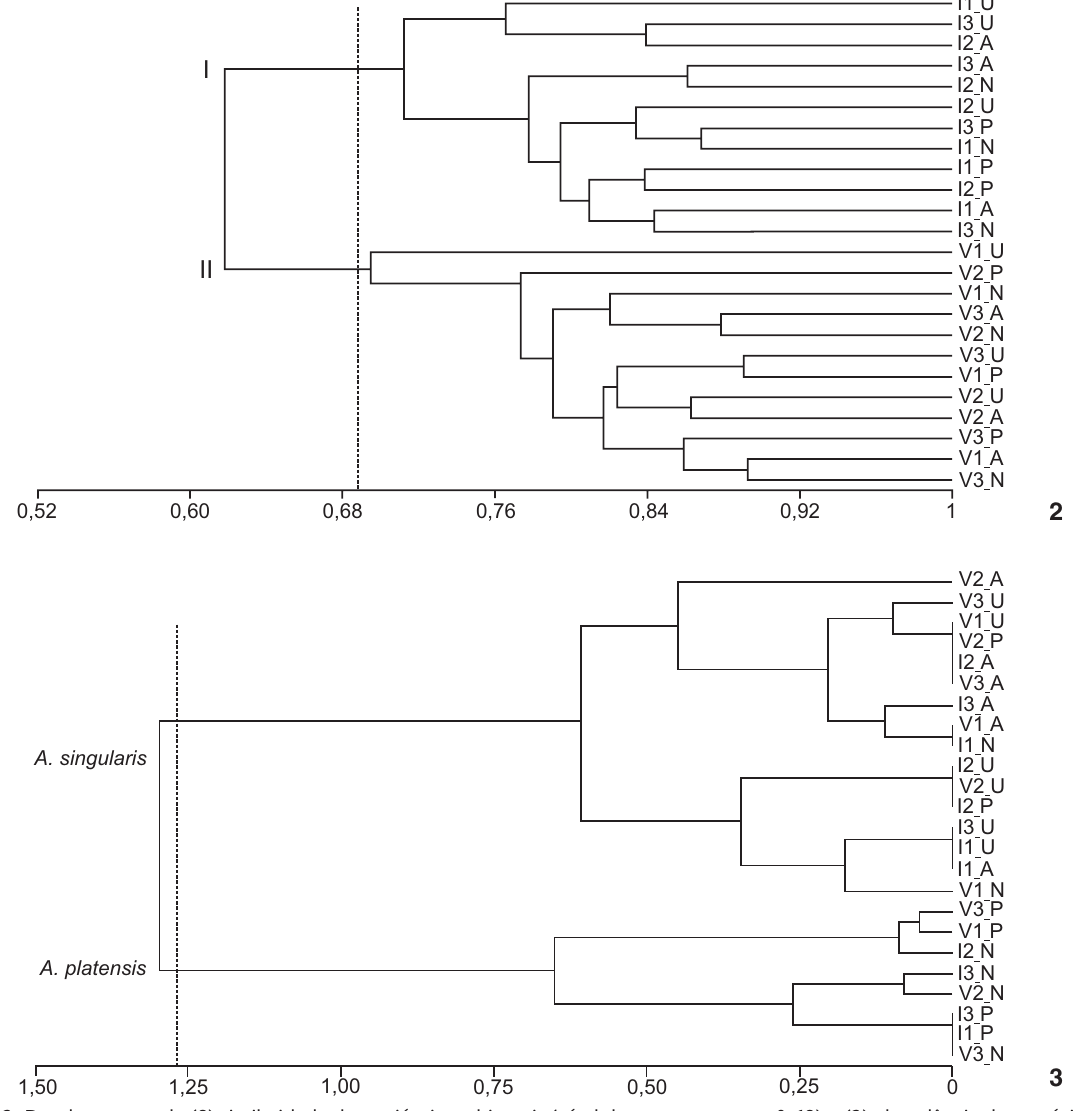
Figuras 2-3. Dendrogramas de (2) similaridade das variáveis ambientais (nível de agrupamento = 0,69) e (3) abundância das espécies de Aegla em função do uso da terra (nível de agrupamento = 1,28) na bacia hidrográfica do Rio Jacutinga, Rio Grande do